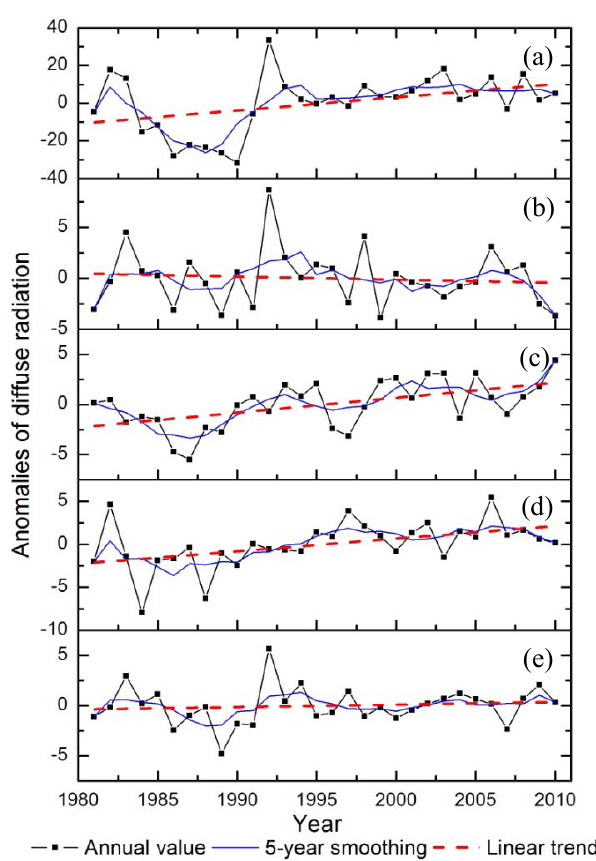
Fig. 4. Anomalies of annual and seasonal diffuse radiation averaged Figure 4. Anomalies of annual and seasonal diffuse radiation averaged all over China from 2 all across China from 1981 to 2010 ( a denotes annual diffuse radi- ation; unit: MJm − 2 yr − 1 . Panels b , c , d and e denote seasonal dif- 1981 to 2010 ( a denotes annual diffuse radiation; unit: MJ m -2 yr -1 . b , c , d and e denote 3 fuse radiation of spring, summer, autumn and winter, respectively; unit: MJm − 2 month − 1 ) . The averages are 2476.98, 245.14, 297.6, seasonal diffuse radiation of spring, summer, autumn and winter respectively; unit: MJ m -2 4 169.39 and 120.13, respectively. month -1 ). The averages are 2476.98, 245.14, 297.6, 169.39 and 120.13 respectively. 5